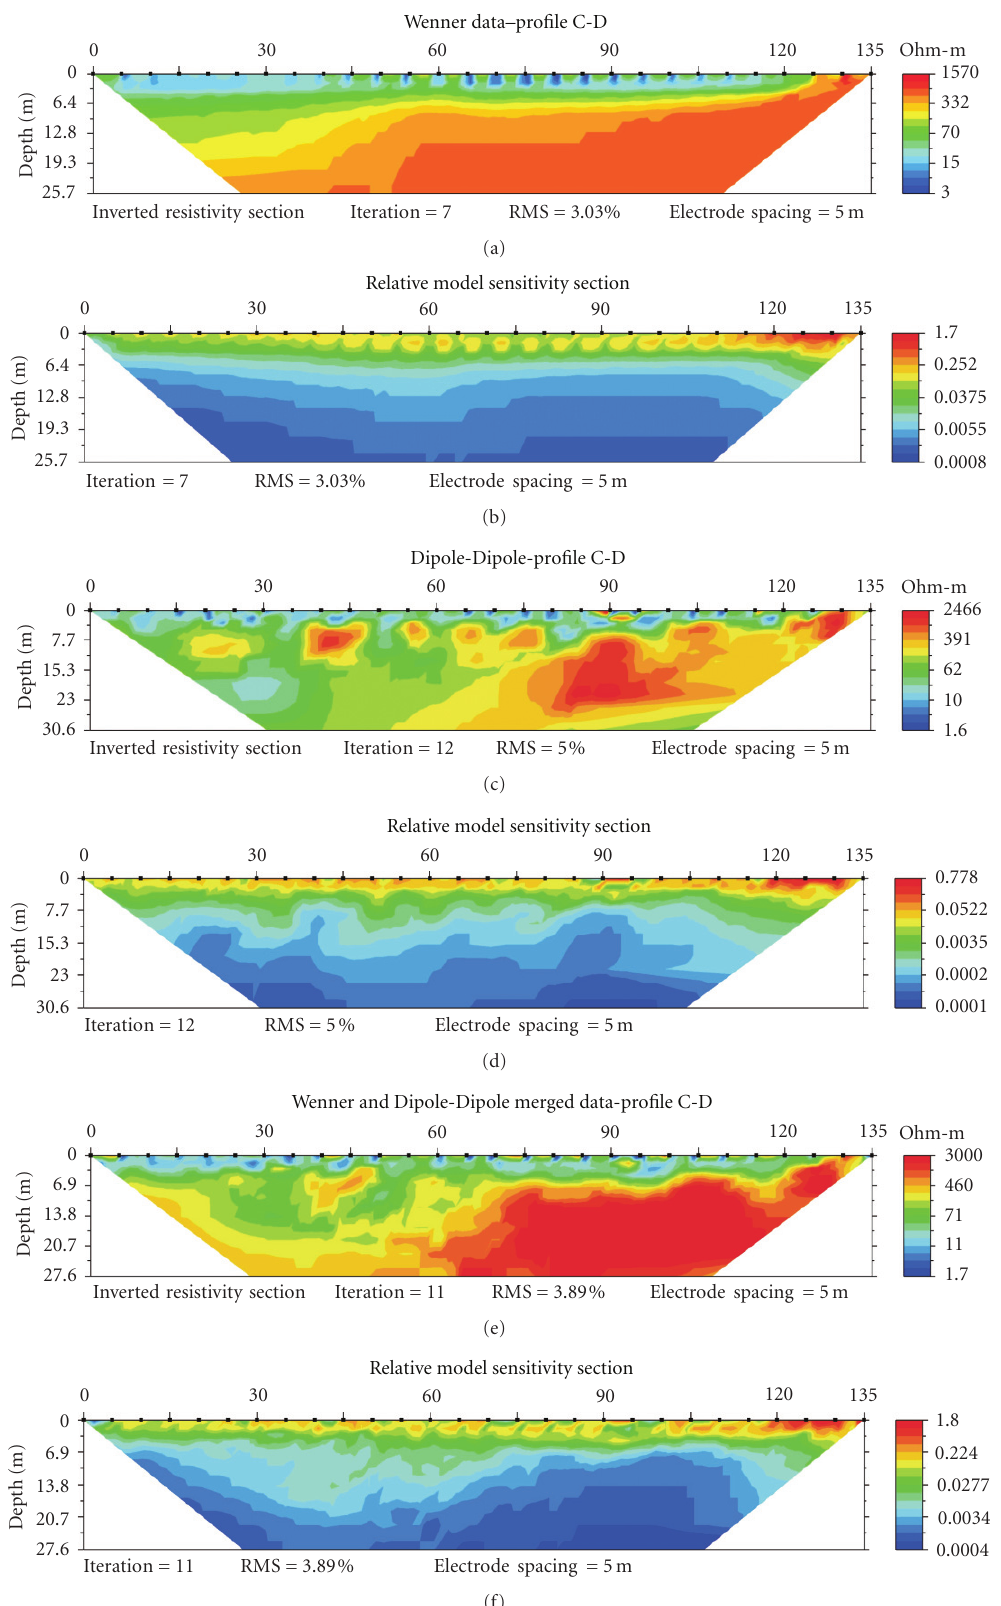
Figure 8: Resistivity sections constructed from Wenner, dipole-dipole, and merged Wenner and dipole-dipole data along with their corresponding sensitivity